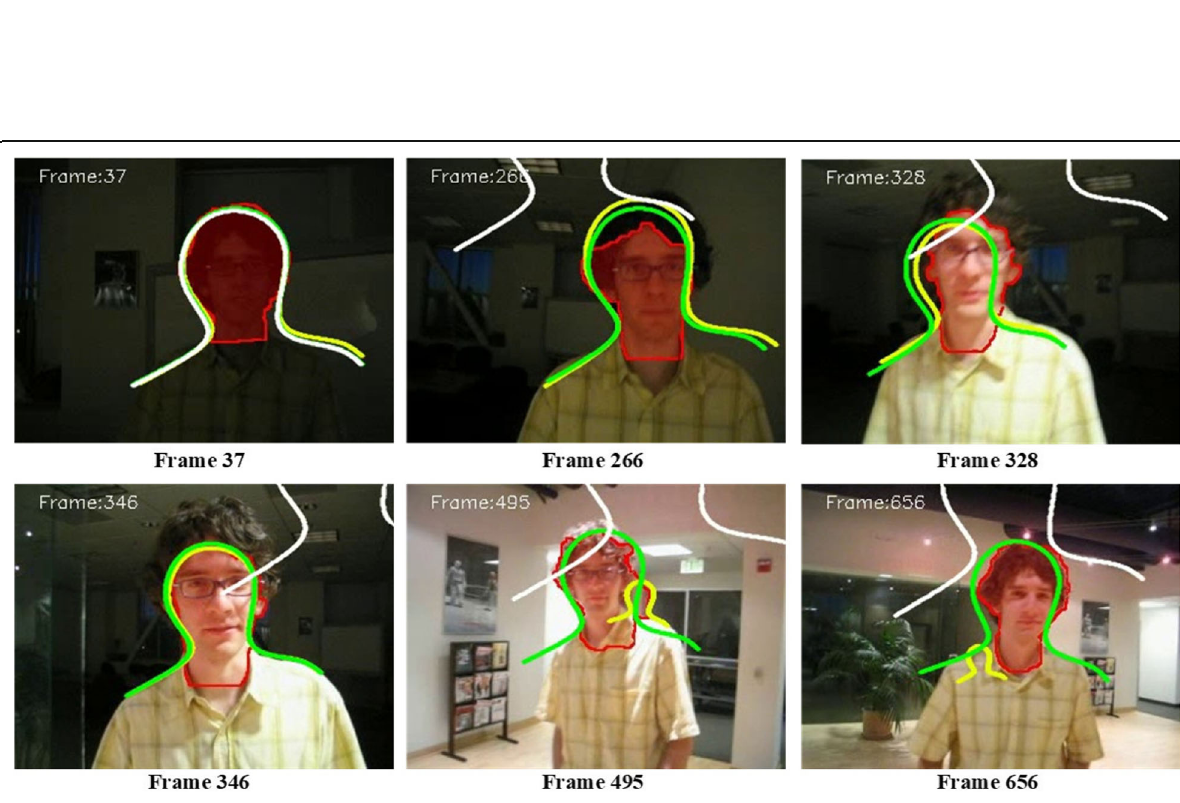
Fig. 10 Tracking result of David. Yellow — UKPF, white — MHMM-UPF, red — Hough Tracker, green — proposed